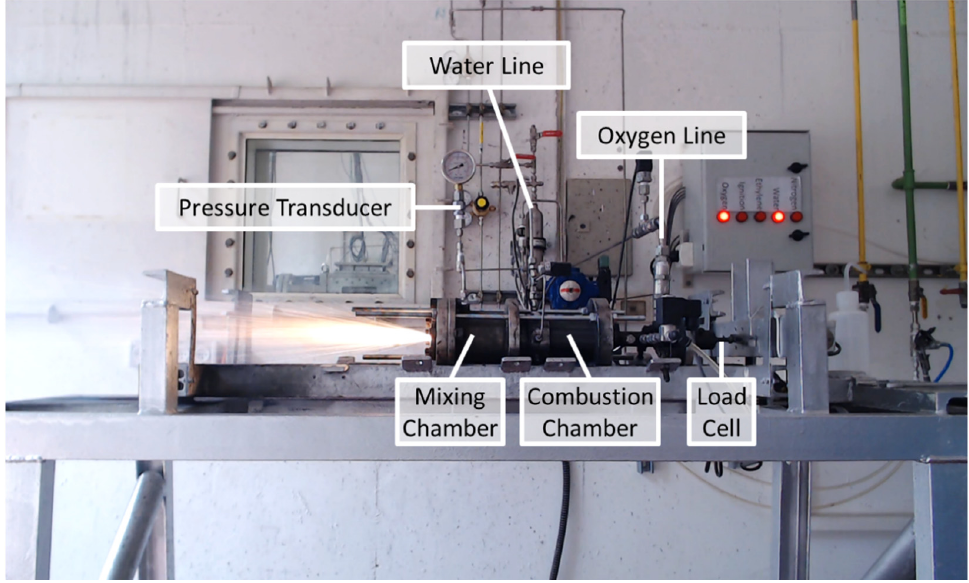
Figure 5. A photograph of the test setup used for static firing experiments of a hydro-reactive, fuel-rich, hybrid-propellant, water-breathing ramjet.